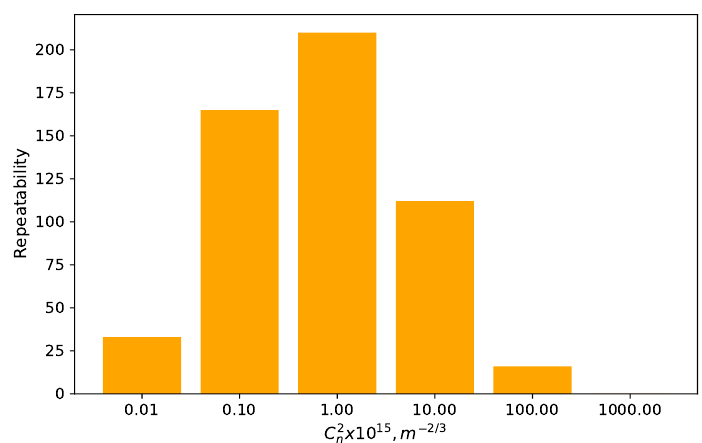
Figure 6. The repeatability of the optical turbulence at the Baykal astrophysical observatory site in